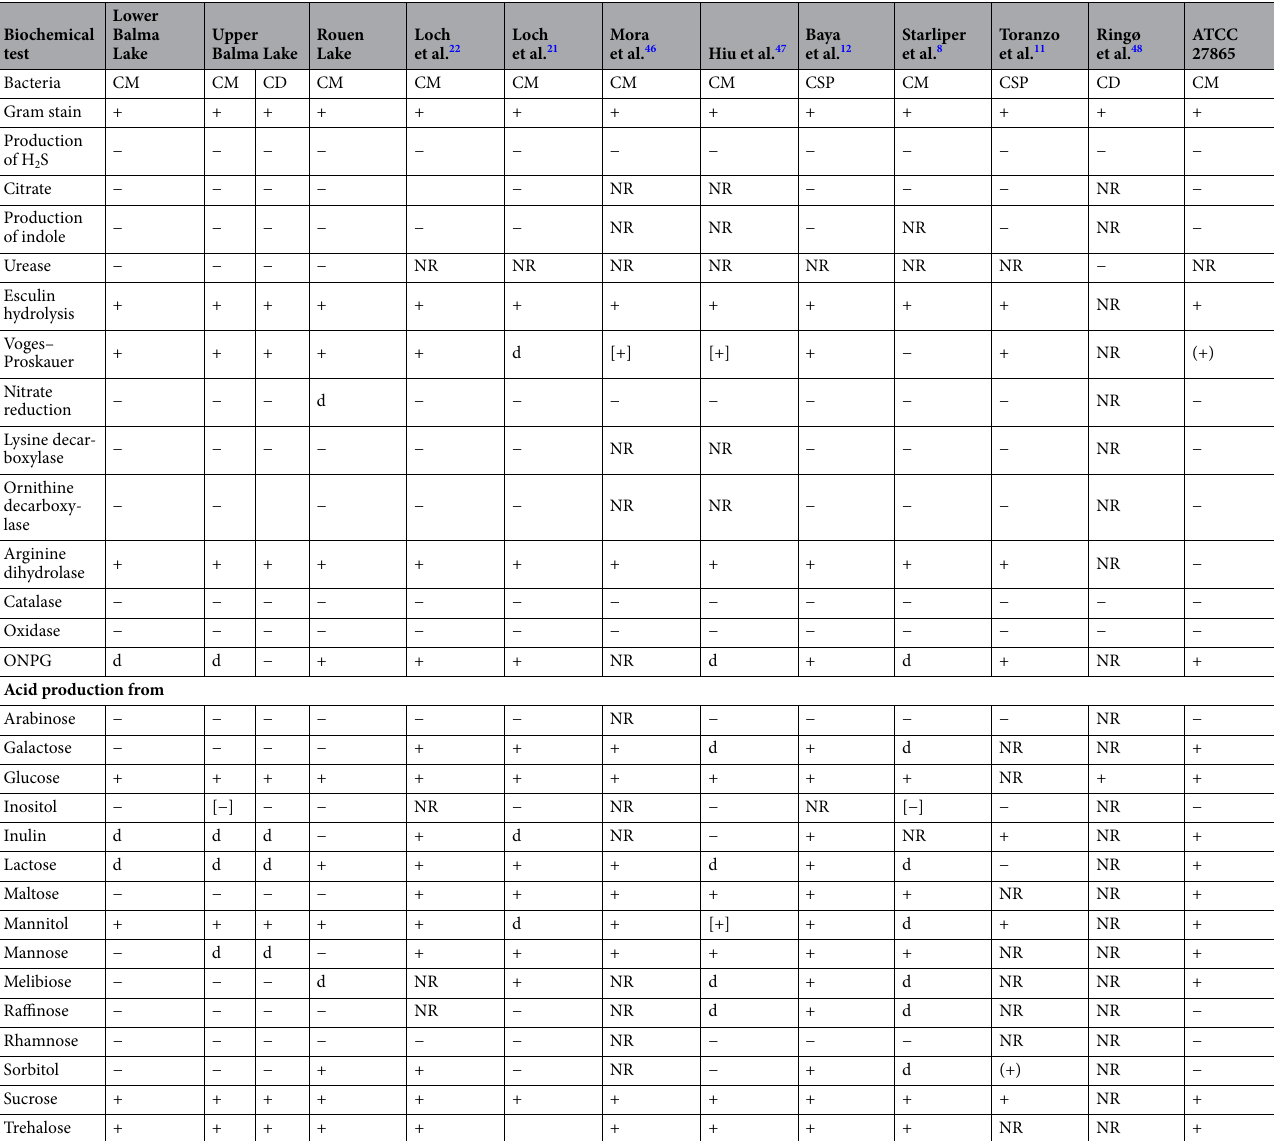
Table 2. Biochemical characteristics of Carnobacterium maltaromaticum (CM) and C. divergens (CD) isolated from the three high-mountain lakes, as well as those of other carnobacteria strains and closely related carnobacteria ( Carnobacterium spp.; CSP) recovered from fish species. +, positive reaction; −, negative reaction; (+), weak and/or delayed positive reaction; [+], 76–89% positive; [−], 11–25% positive; d, 11–89% positive; NR, not